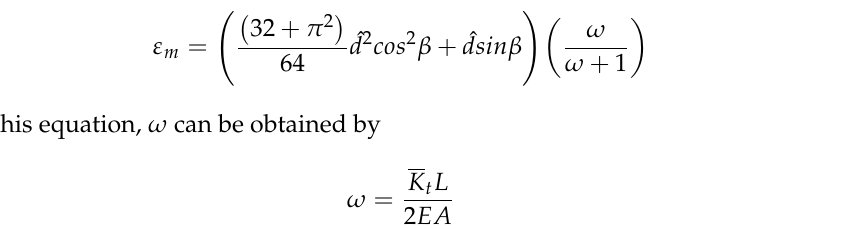
Figure 2. Length ratio ( a ) diagram for b values between 0 and 20, ( b ) diagram for b values between 20 and 150 [10].